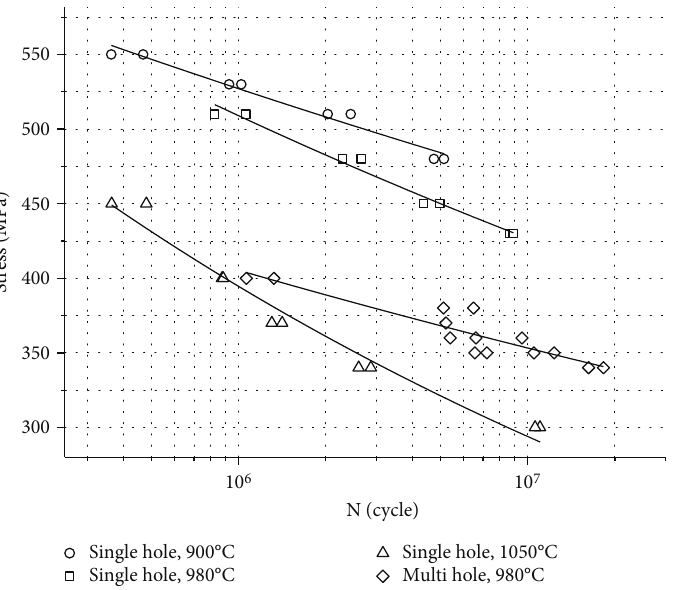
Figure 12: Fitted S-N curve.